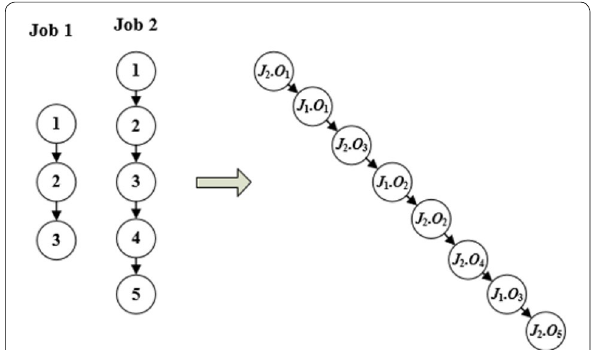
Figure 5 Using online dispatching rules for machine